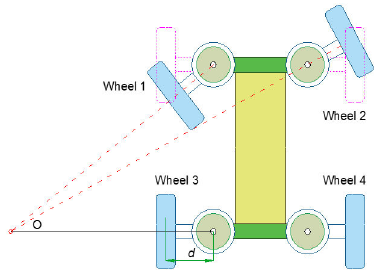
Figure 3. Steering schematic of the wheeled-robot chassis. Wheels 1, 2, 3, and 4 express the left front, right front, left rear, and right rear wheels,